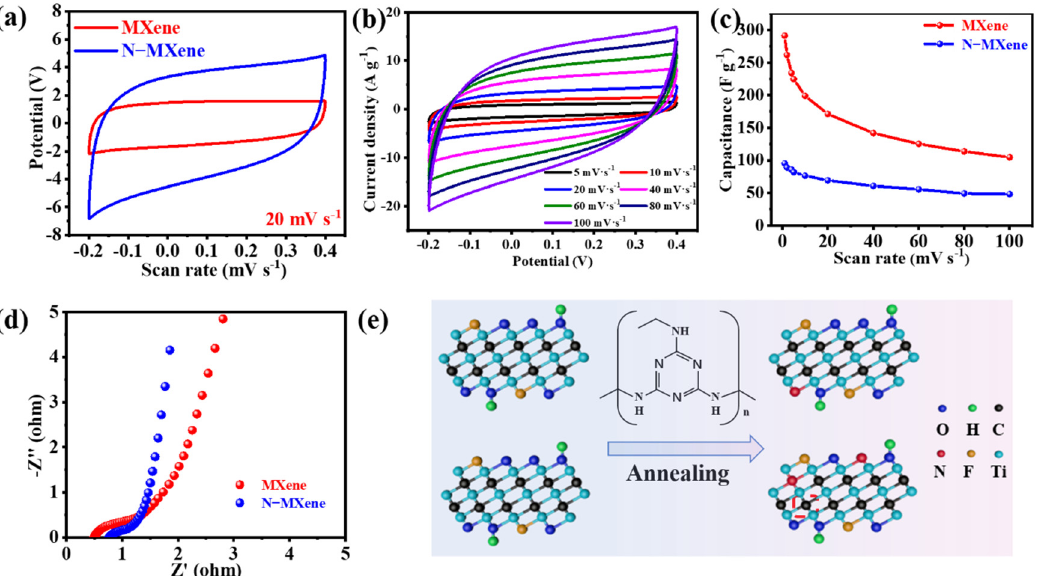
Figure 4. Electrochemical measurement by the three-electrode system: ( a ) CV curves of the N-MXene and MXene electrodes; ( b ) CV curves of the N-MXene at different scan rates ranging from 1 to 100 mV s − 1 ; ( c ) specific capacitance of the N-MXene and MXene electrode at various scan rates; ( d ) Nyquist electrochemical impedance spectra; ( e ) schematic diagram of nitrogen atom doping.